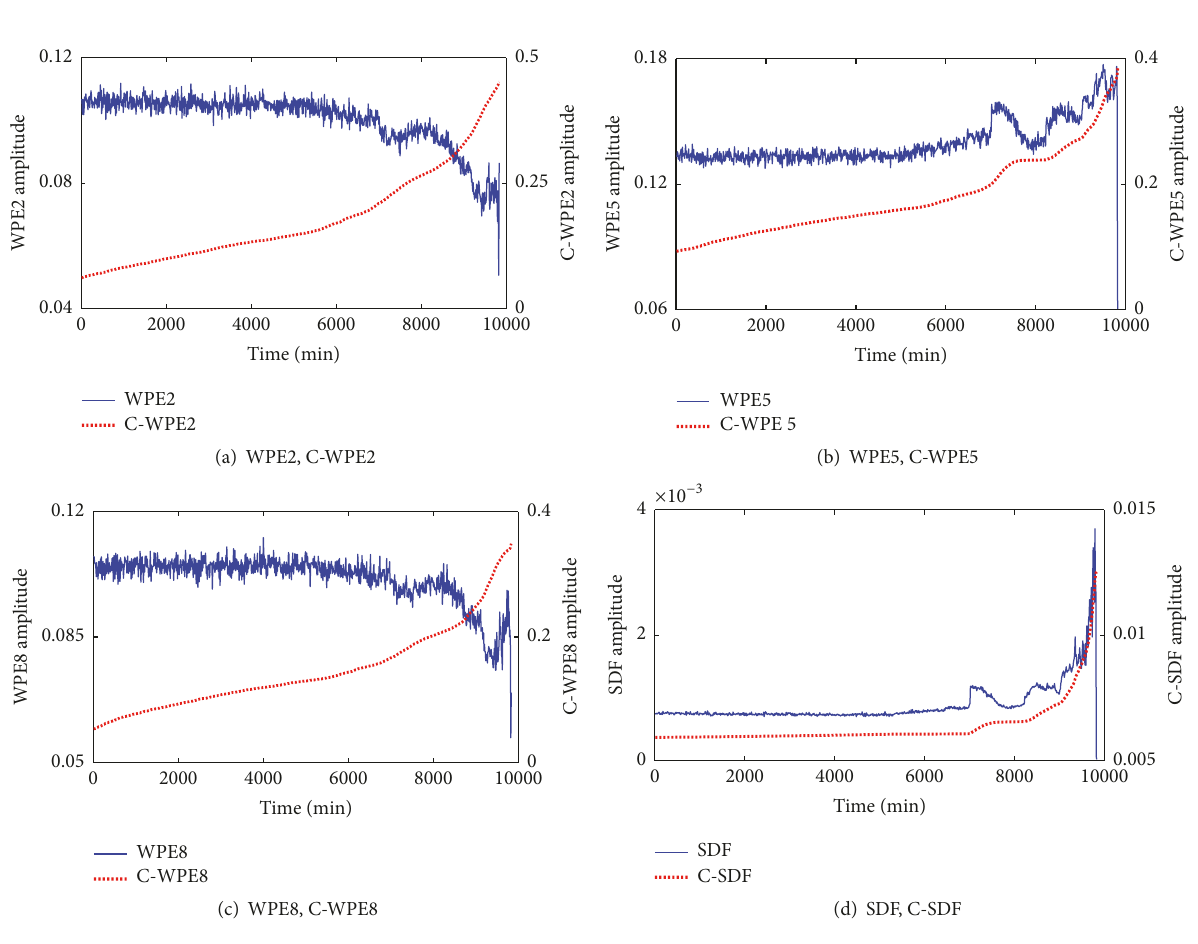
Figure 8: First four preferred features and corresponding cumulative features. Table 3: Evaluation results of cumulative features of the first eight best original